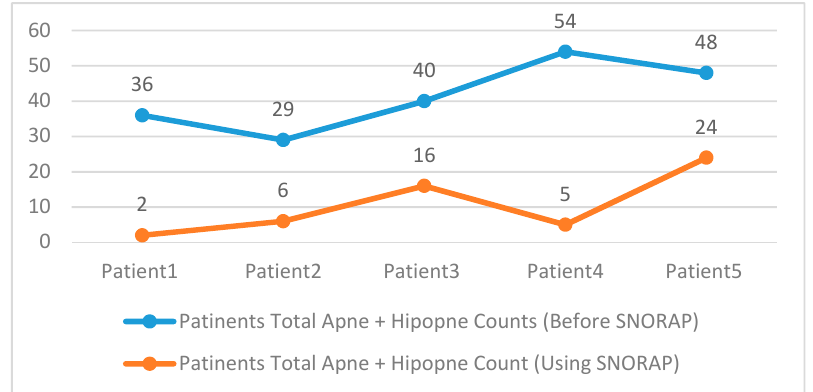
Figure 10. Patient’s Total Apnea + Hypopnea Counts.